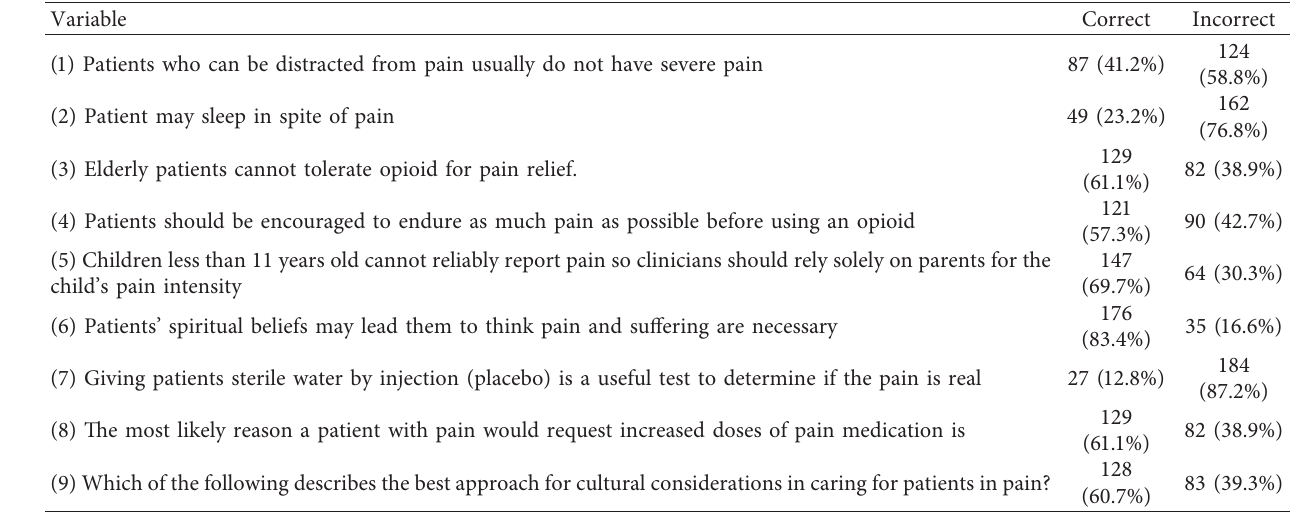
Table 3: Attitude towards pain